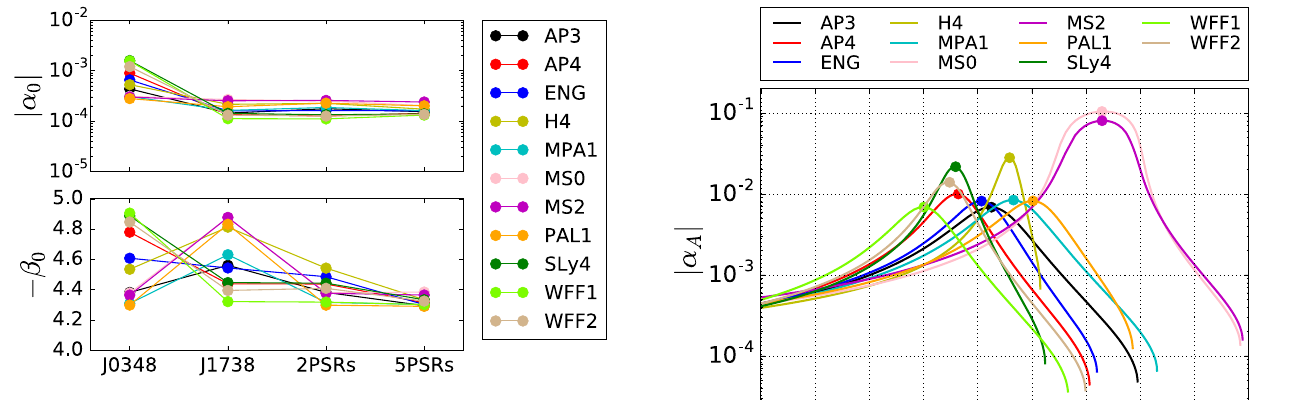
FIG. 4. Marginalized upper limits on j α 0 j (upper panel) and − β 0 (lower panel) at 90% C.L. These limits are obtained from PSRs J 0348 þ 0432 ( J0348 ), J 1738 þ 0333 ( J1738 ), a combination of them ( 2PSRs ), and a combination of PSRs J 0348 þ 0432 , J 1012 þ 5307 , J 1738 þ 0333 , J 1909 − 3744 , and J 2222 − 0137